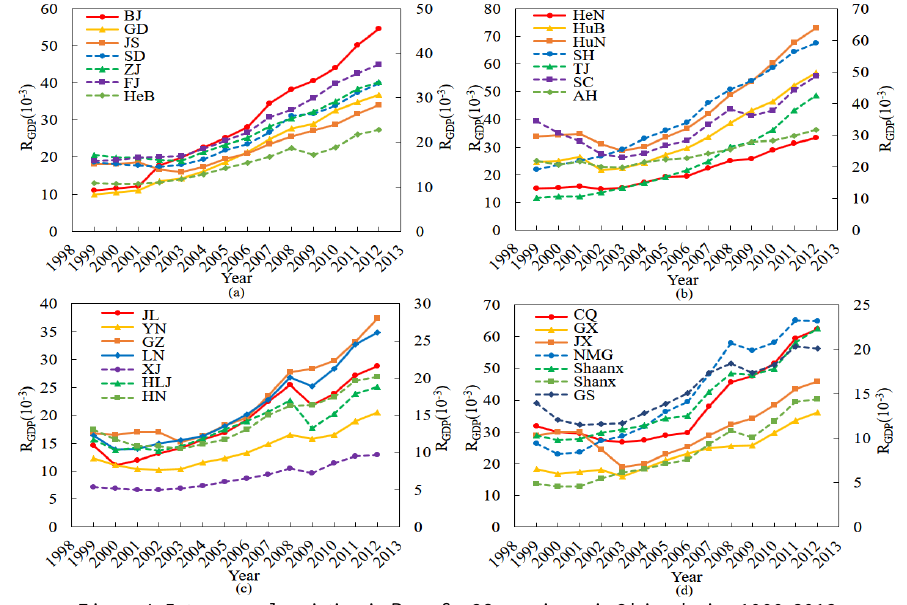
Figure 4. Inter-annual variation in R GDP for 28 provinces in China during